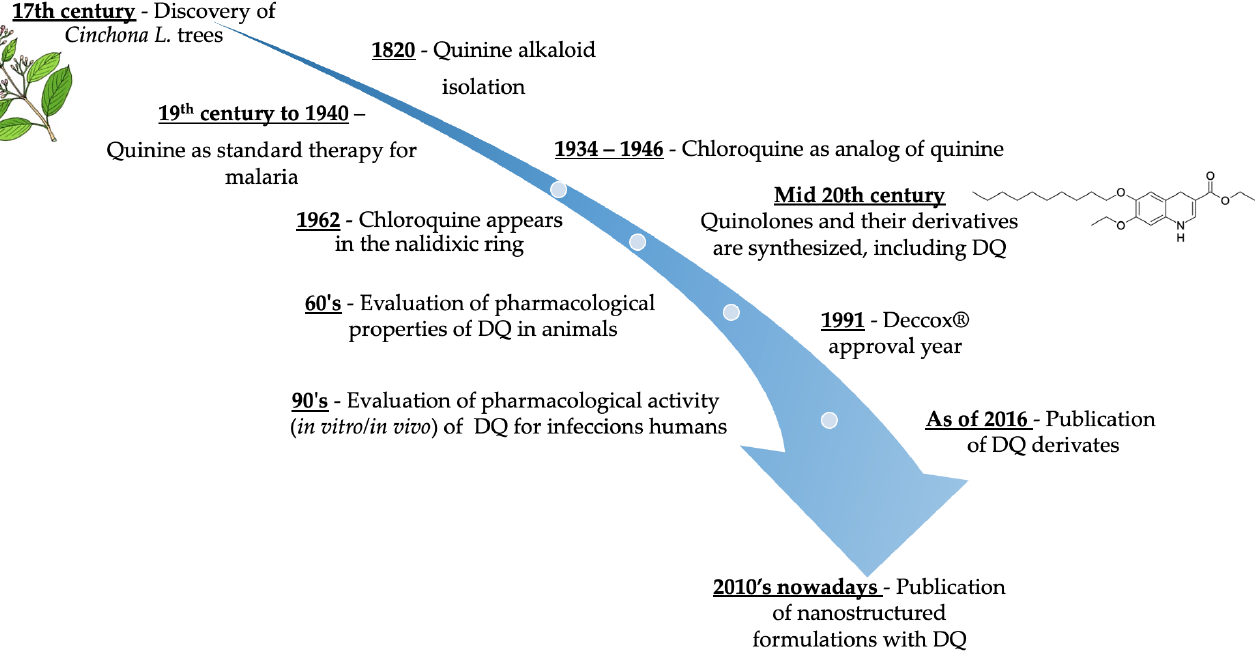
Figure 3. Timeline showing the history of DQ, from raw material to its approval as a drug in